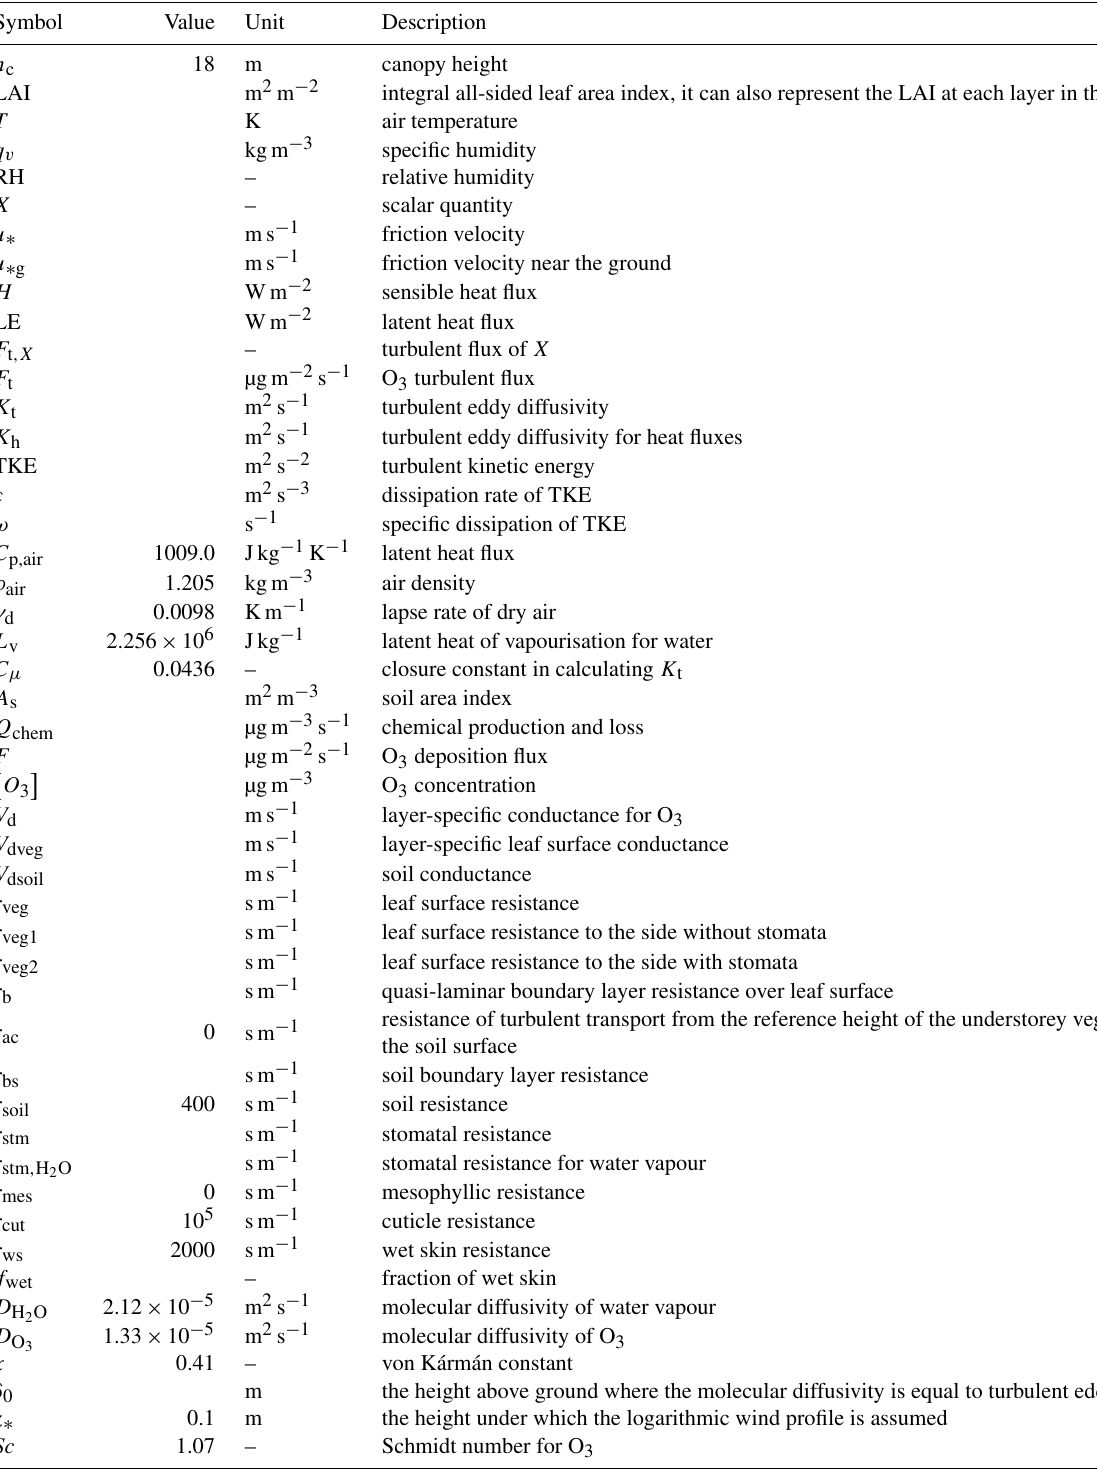
Table A1. Table of